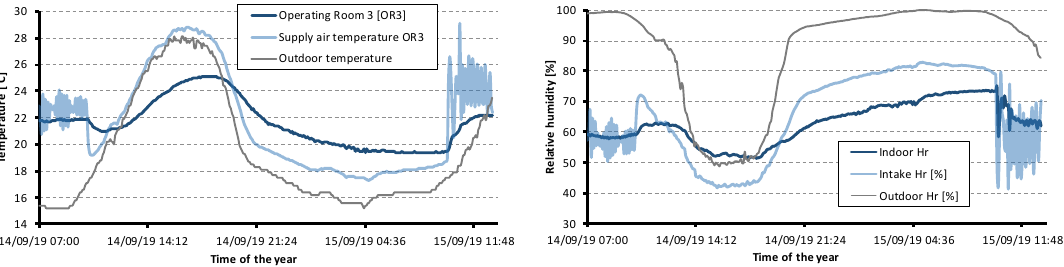
Figure 9. Temperature and RH in OR3 during the second experimental data campaign.